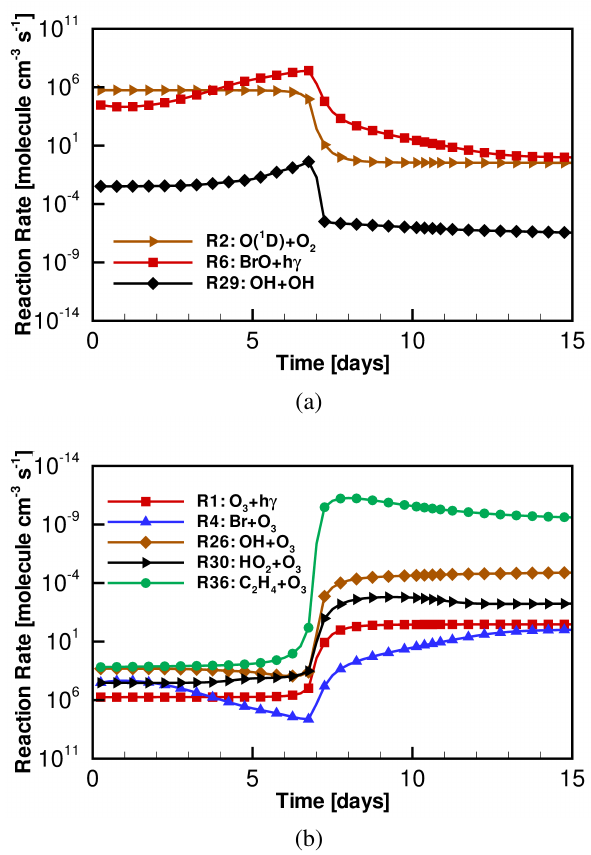
Fig. 4. Temporal evolution of ozone-relevant reaction rates in a 200m boundary layer height: (a) formation, (b) depletion. Note that a reverse direction of vertical axis is used in the bottom panel.